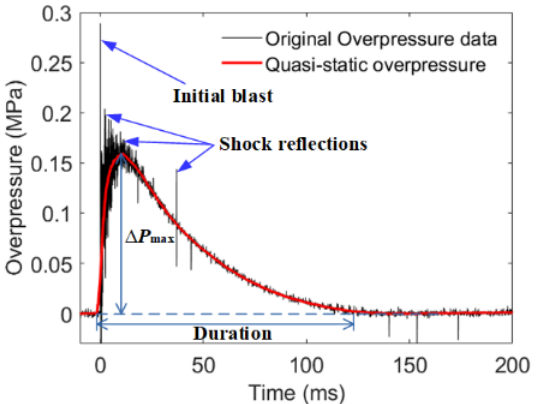
Figure 5. The typical overpressure in the chamber varied with